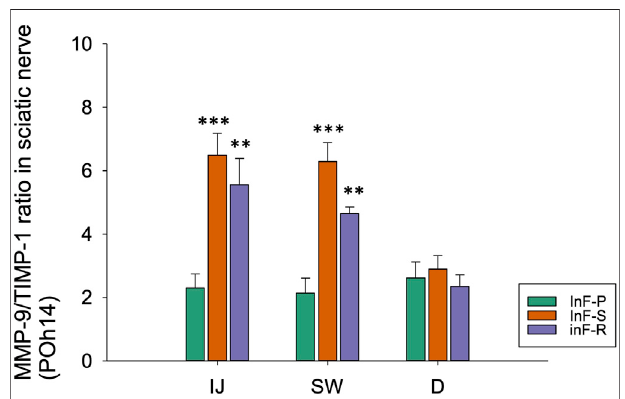
FIGURE 7 | By western blotting, relative expression ratios of MMP-9/ TIMP-1 in three distinct cross-sections of sciatic nerve from needle piercing group (InF-P), intrafascicular saline injection group (InF-S) and intrafascicular ropivacaine injection group (InF-R) were shown. The MMP-9/TIMP-1 total protein expression ratio is calculated based on the β -actin normalized value of MMP-9 ( Figures 6B – D ) and TIMP-1 ( Figures 5B,D,F ) protein expressionsrespectively,and relative tothenormalizedprotein expressions in sham